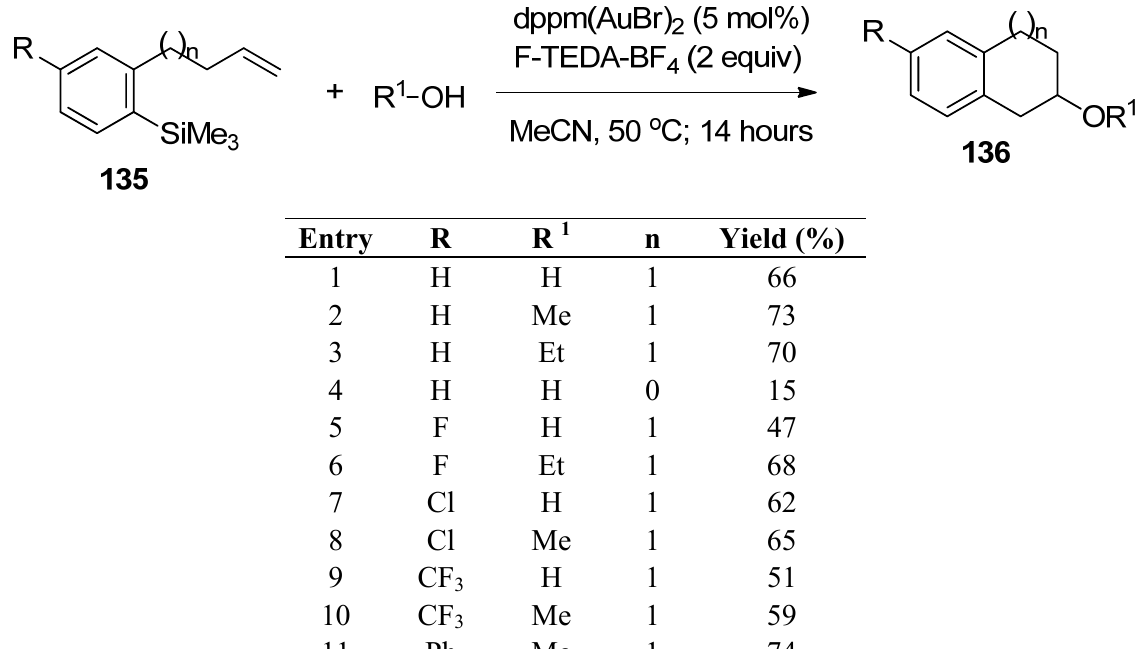
mediated intramolecular coupling 4